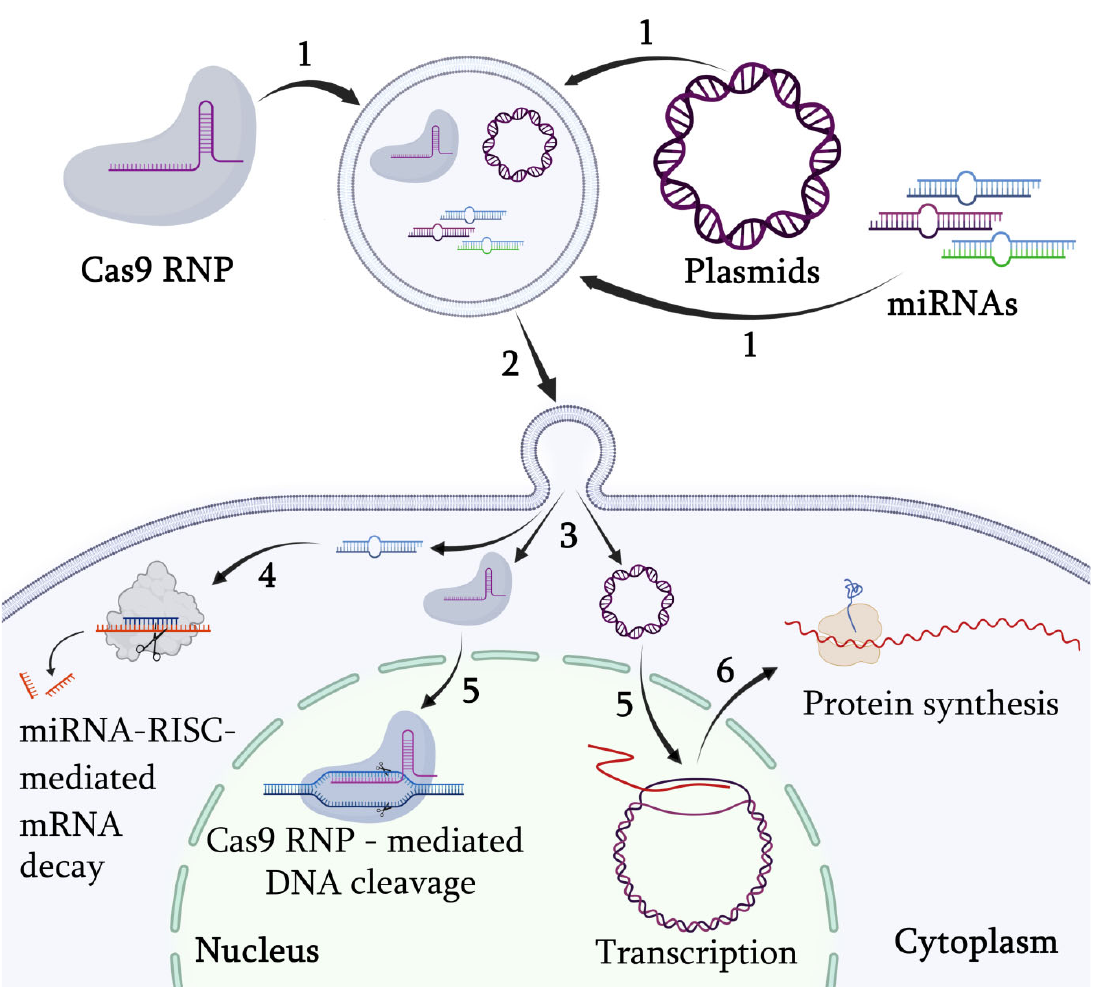
Figure 4. The use of exosomal vesicles for genetic material delivery. 1—exosome loading with therapeutic macromolecules; 2—exosome delivery; 3—genetic material release upon fusion of the exosome with the cell plasma membrane; 4—miRNA—mediated regulation of gene expression through activation of the RNA ‐ induced silencing complex (RISC); 5—nuclear import of Cas9—ribonucleoprotein (RNP) and plasmid DNA; 6—mRNA nuclear export for translation.